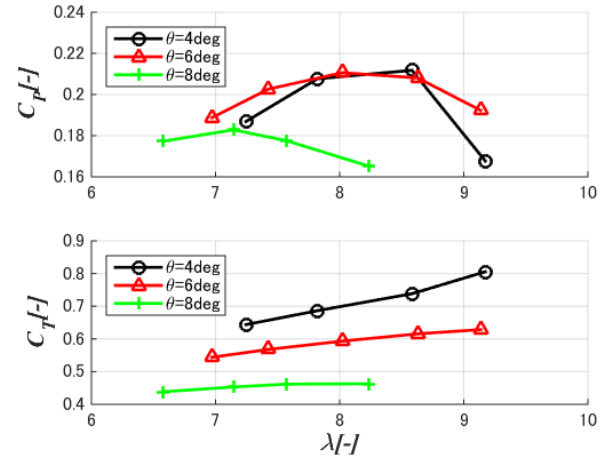
Figure 5. Relationship between the power ( C P ) and thrust ( C T ) coefficients and the tip speed ratio. θ, blade pitch angle.